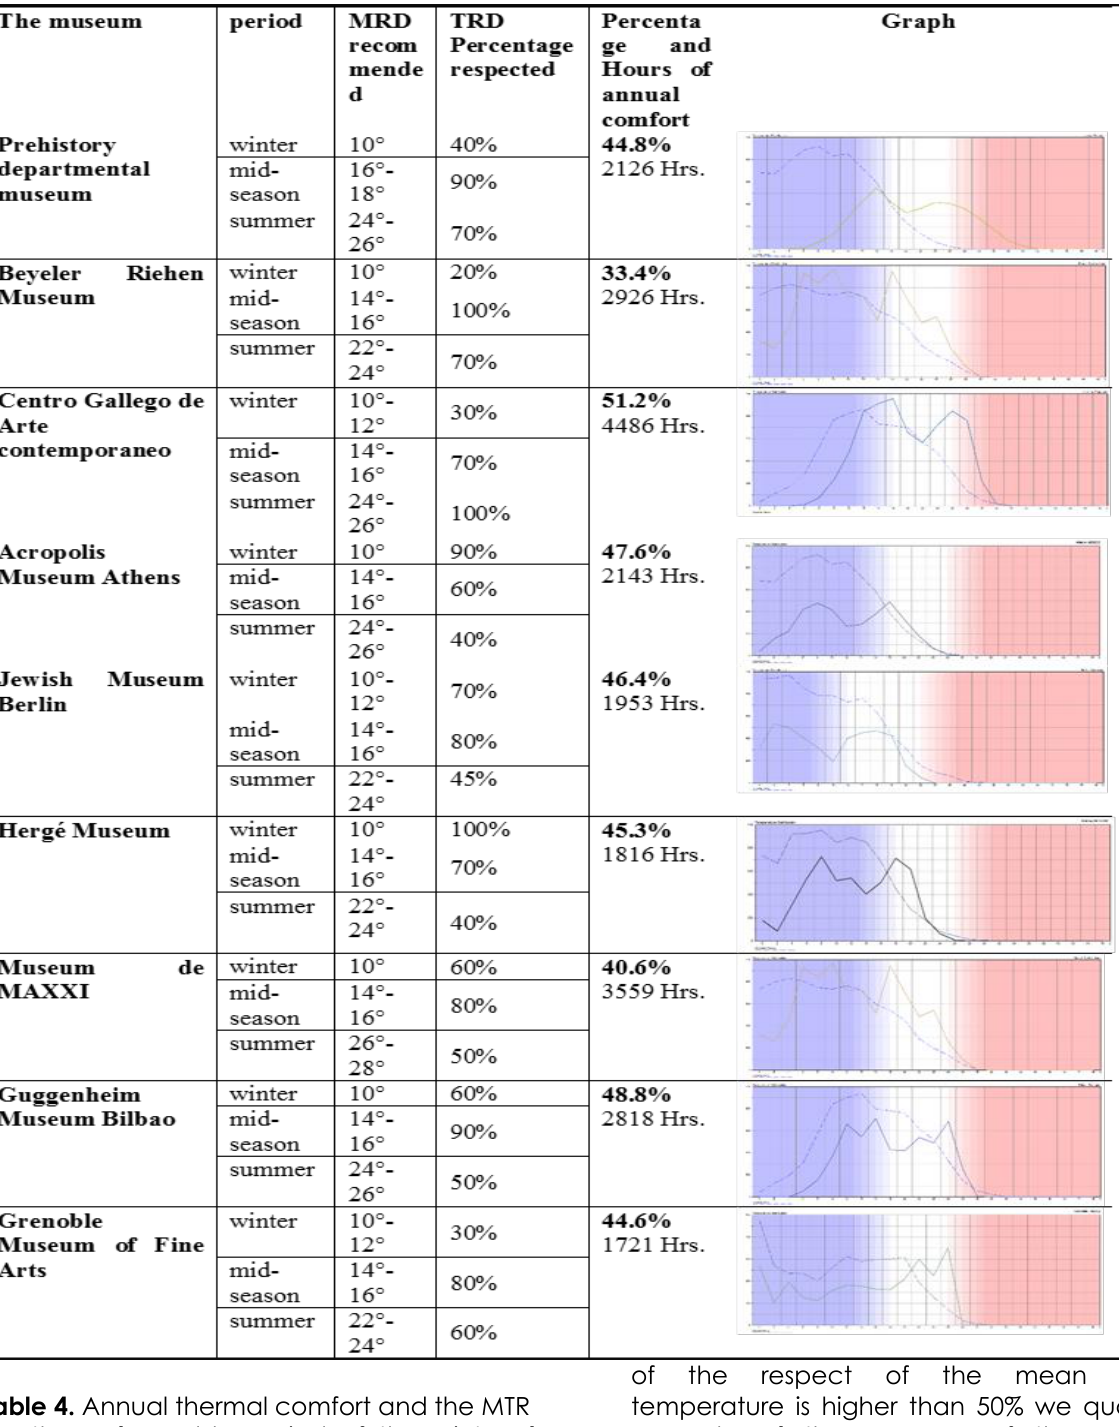
Table 4. Annual thermal comfort and the